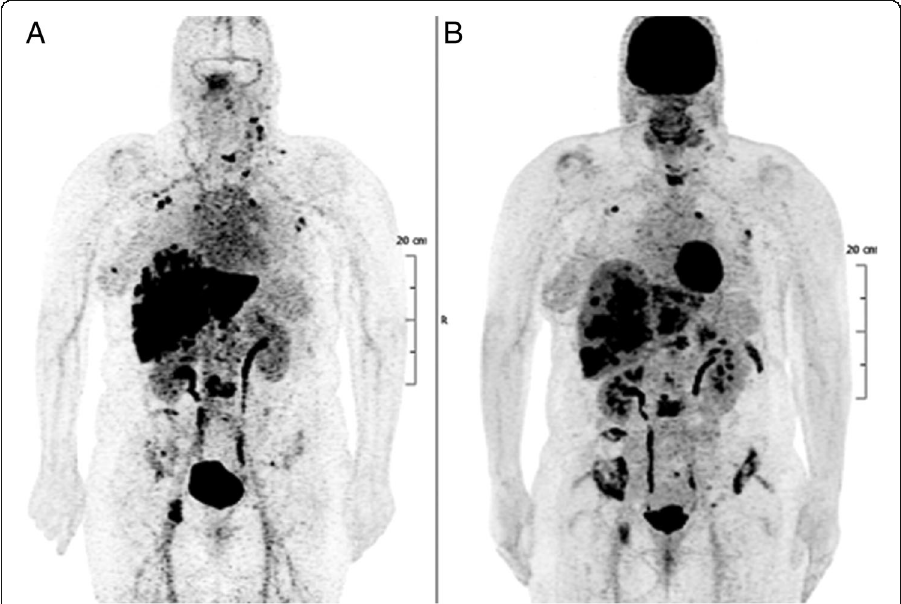
Fig. 2 PET imaging of a patient with metastatic breast carcinoma. a Pretargeted immuno-PET performed using the TF2 anti-CEA bispecific antibody and the 68 Ga-labelled IMP-288 peptide detects more lesions than FDG-PET ( b